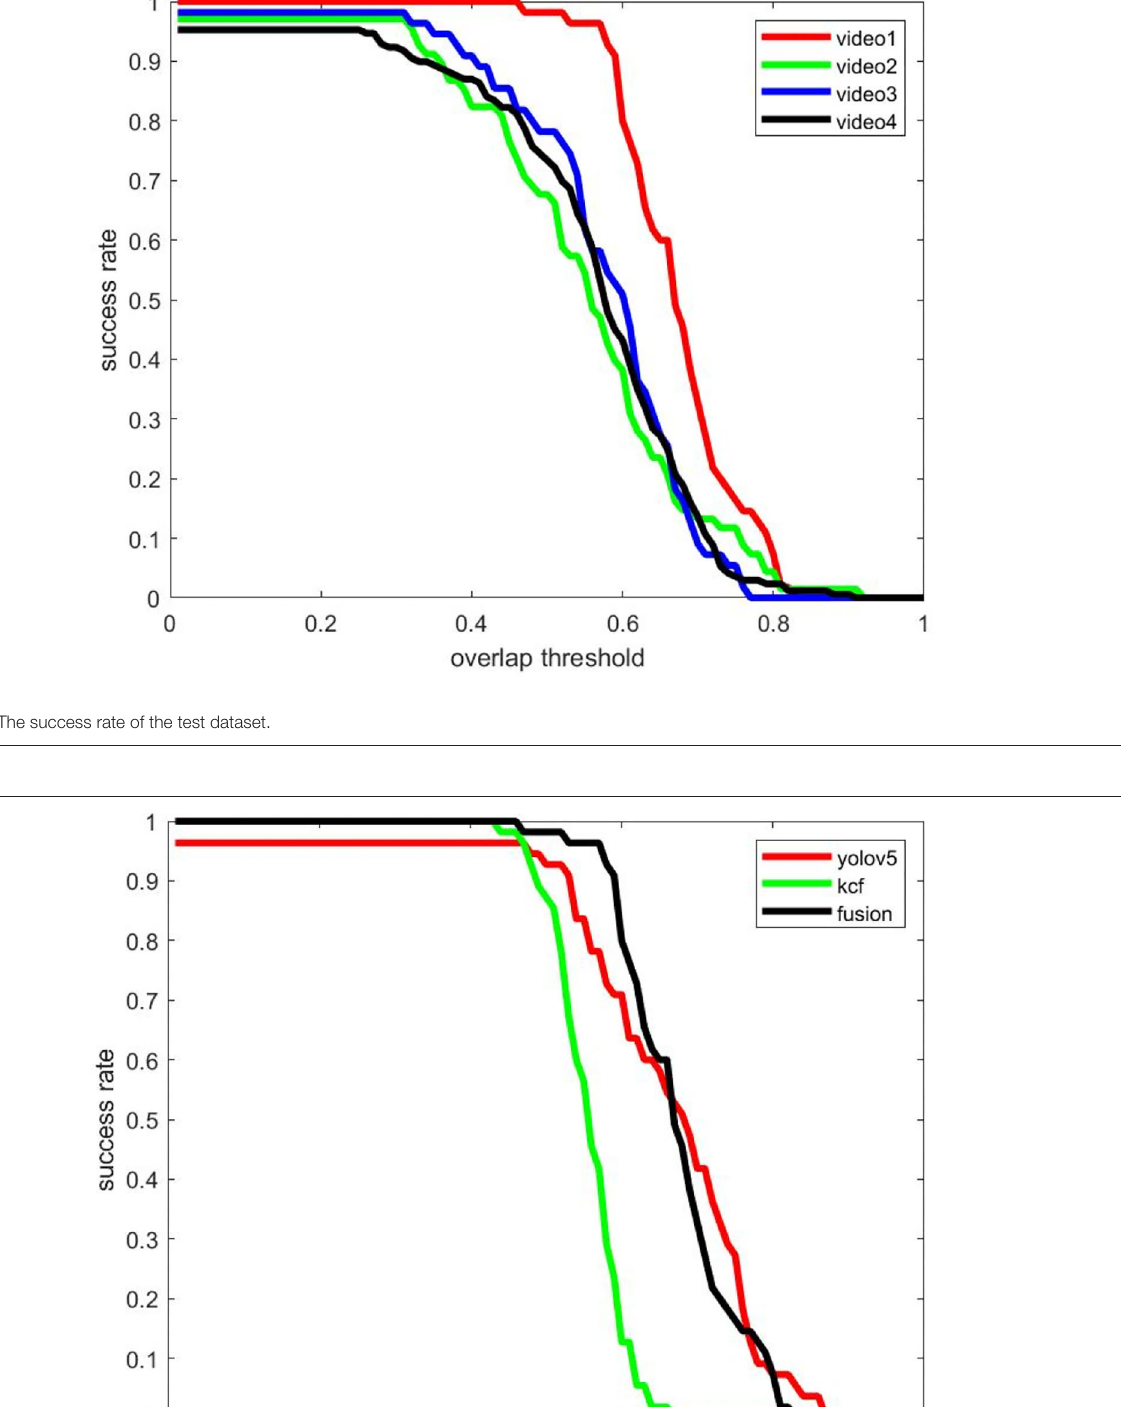
Frontiers in Neurorobotics |